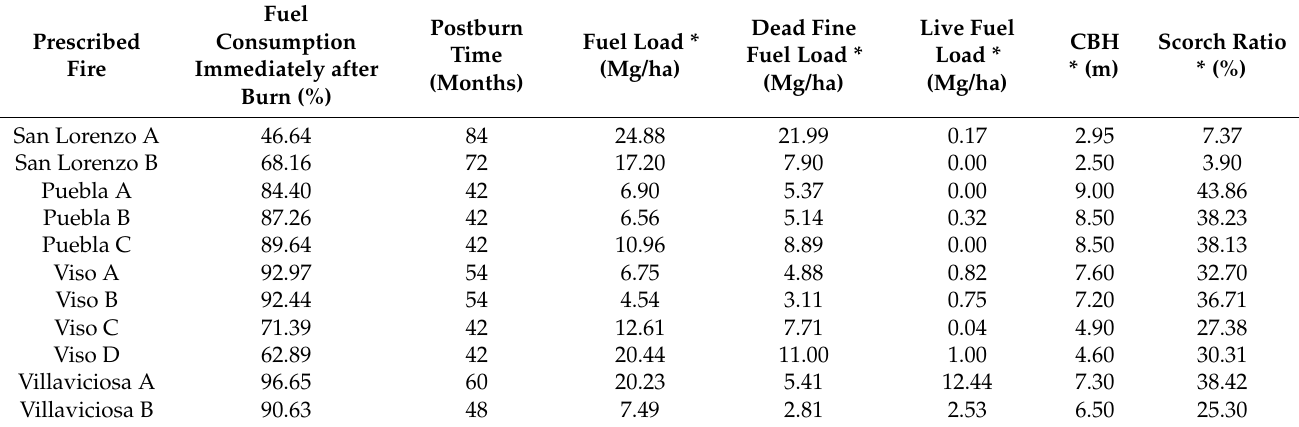
Table 4. Identification of the fuel consumption and prescribed fire effects in the medium